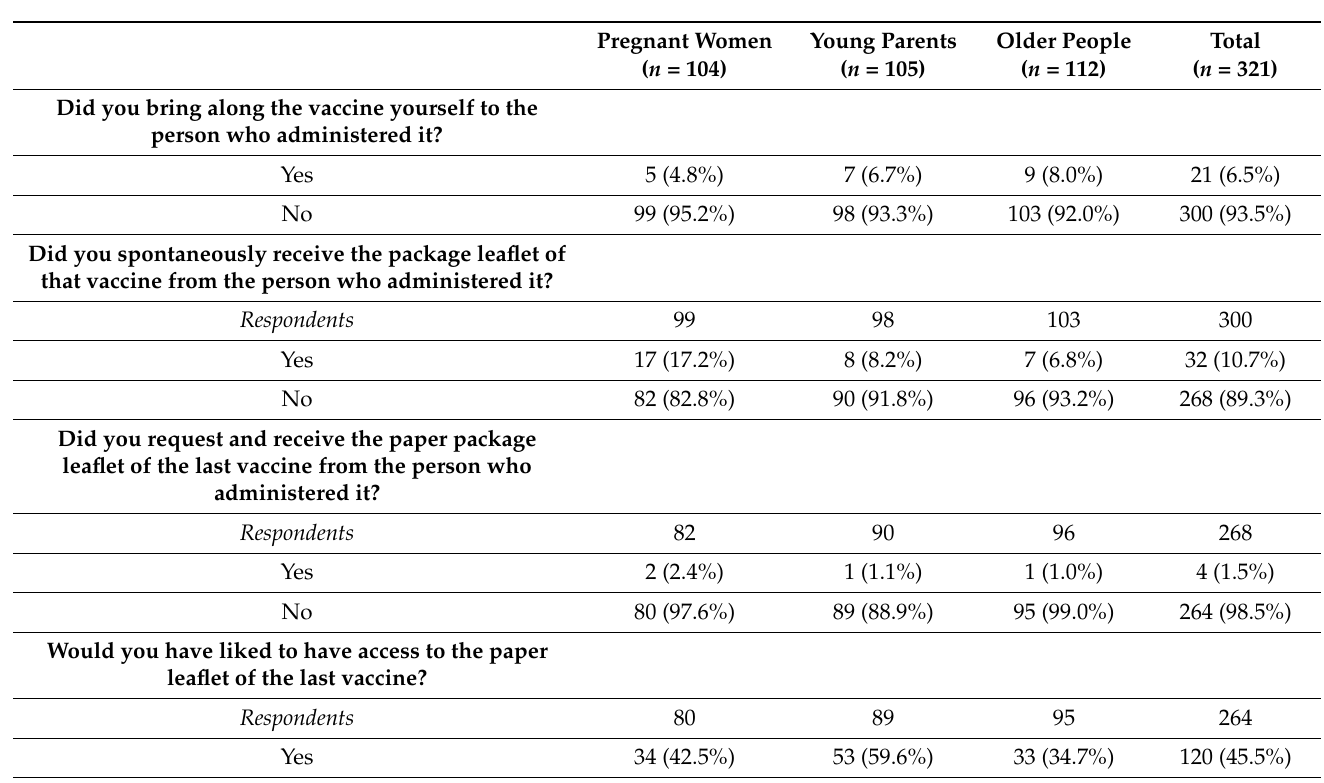
Table 2. Overview of the answers of the respondents about the vaccine leaflet of the most recent vaccination, for the three target